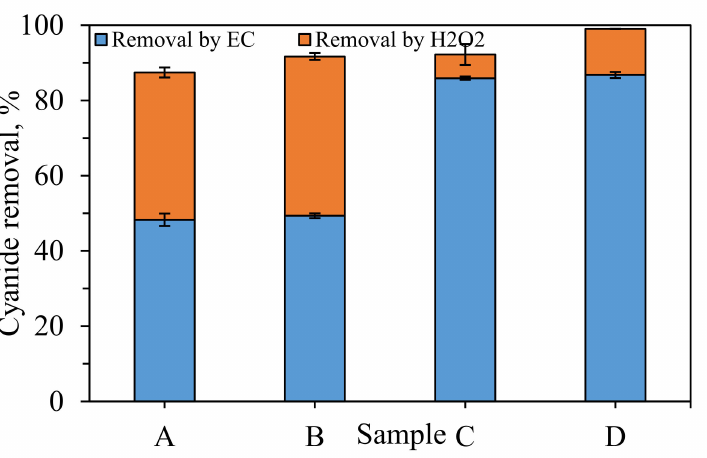
Figure 8. Removal of cyanide with electrochemical crystallization followed by oxidation of residual cyanide using H 2 O 2 . Sample A: initial concentration of 10 mg CN − /L, H 2 O 2 :CN = 1:1. Sample B: initial concentration of 10 mg CN − /L, H 2 O 2 :CN = 1.5:1. Sample C: initial concentration of